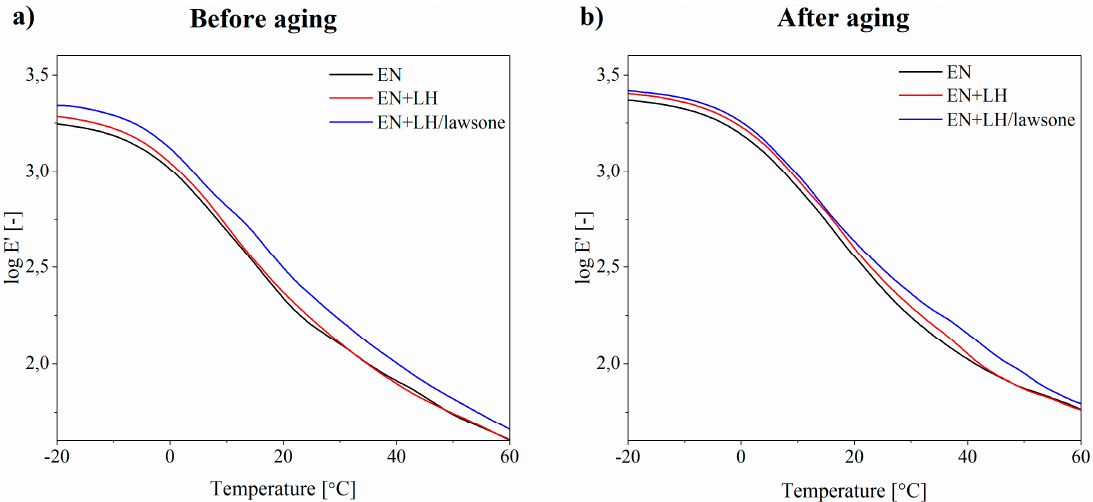
Figure 9. Temperature dependence of the storage modulus (E’) logarithm at 5 Hz for EN, EN + LH and EN + LH / lawsone composites before ( a ) and after ( b ) 350 h of aging.